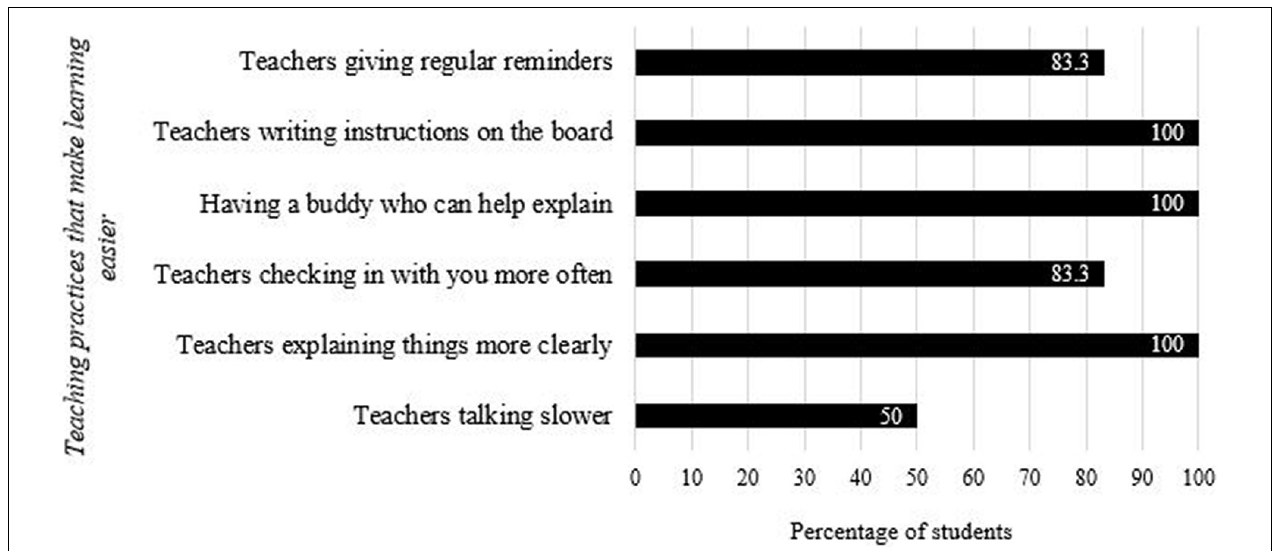
FIGURE 2 | Student responses to the “What helps you to learn?” visual